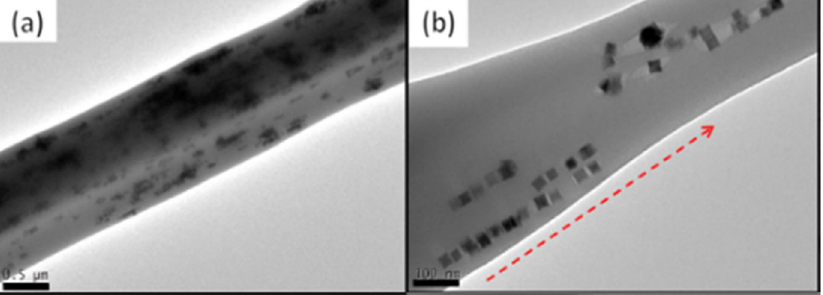
Figure 12. TEM images of the DOX-loaded magnetic fibers. ( a )-Images of PCL-MNPs-DOX fibers. In ( b ) the spontaneous alignment (red arrow) along the fiber axis can be observed. Reprinted/adapted with permission from Ref. [79]. 2022,